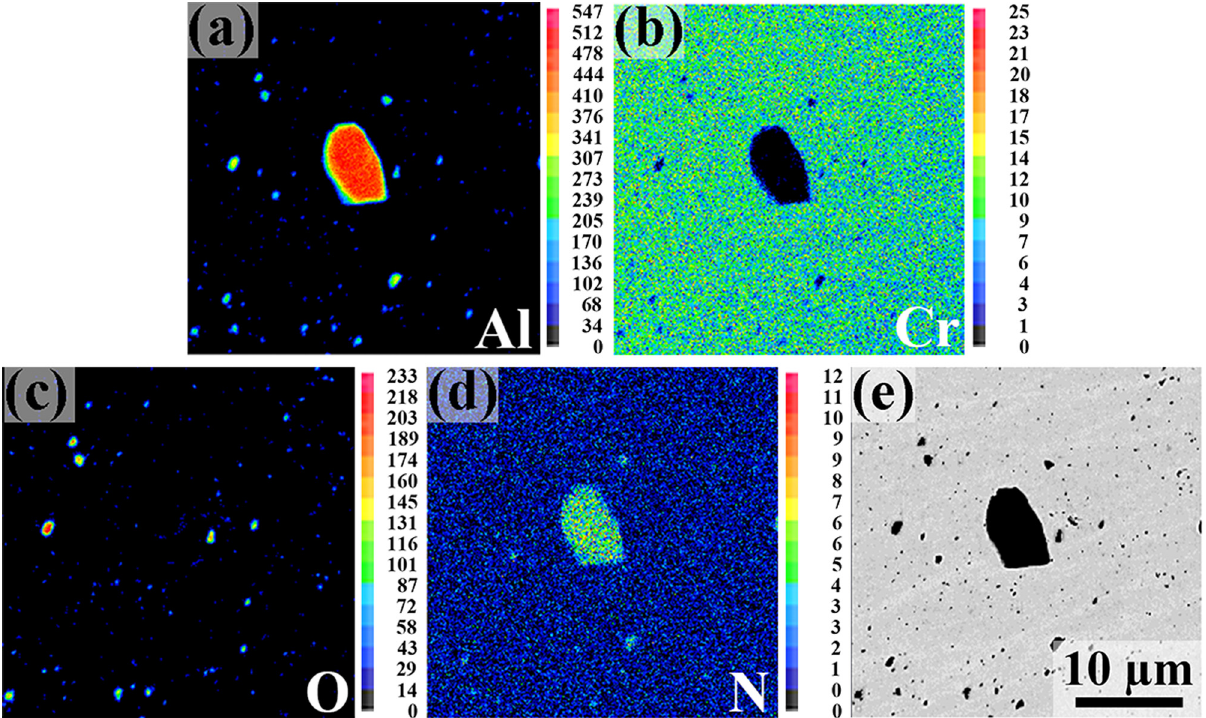
Figure 6: EPMA mapping in the WB showing the spatial distribution of ( a ) Al, ( b ) Cr, ( c ) O, and ( d ) N and ( e ) image of backscattered